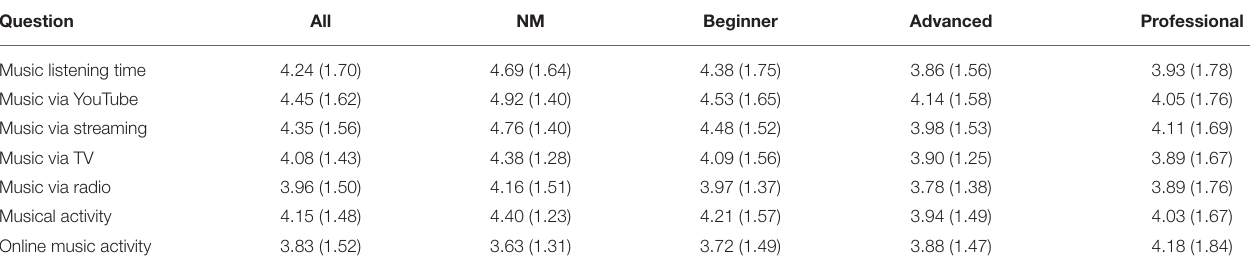
TABLE 18 | Mean and SD of responses to music listening- and activity-related questions, grouped by musicianship. Question All